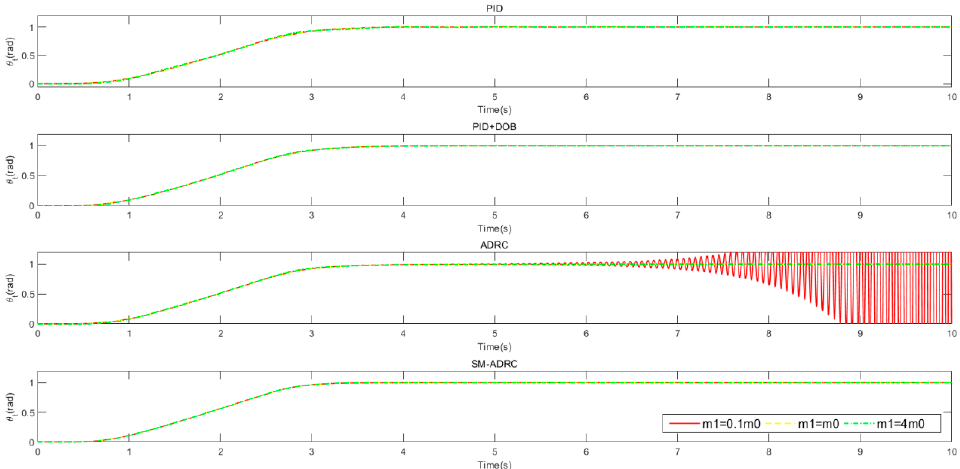
Figure 5. Tracking trajectories of the flexible manipulator tip position with different tip mass values.